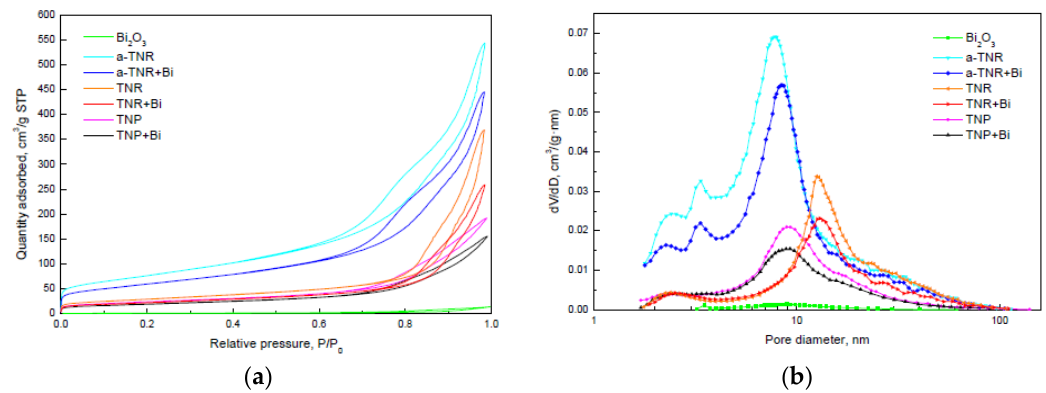
Figure 3. Nitrogen adsorption–desorption isotherms ( a ) and BJH (Barrett, Joyner and Halenda method) pore size distribution of synthesized catalysts ( b ).